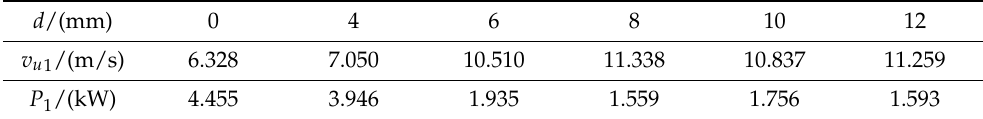
Table 2. The calculation results of disk friction